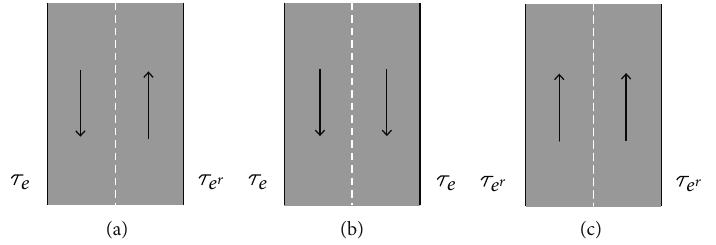
Figure 1: (a) represents a two-way road network, (b) represents the network, if arc e r is reversed in the direction of arc e , and (c) represents the network, if arc e is reversed in the direction of arc e r .